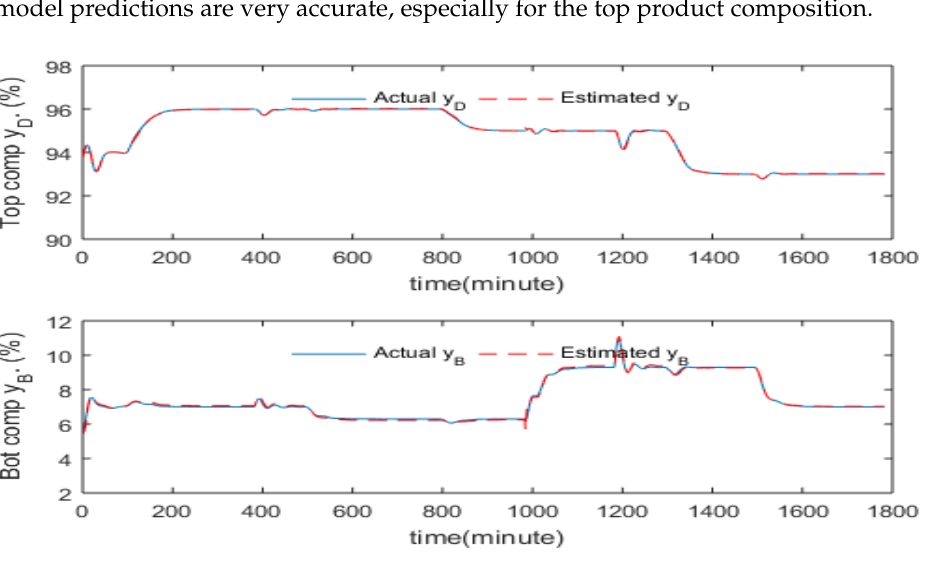
Figure 6. Predictions from the PCR model.